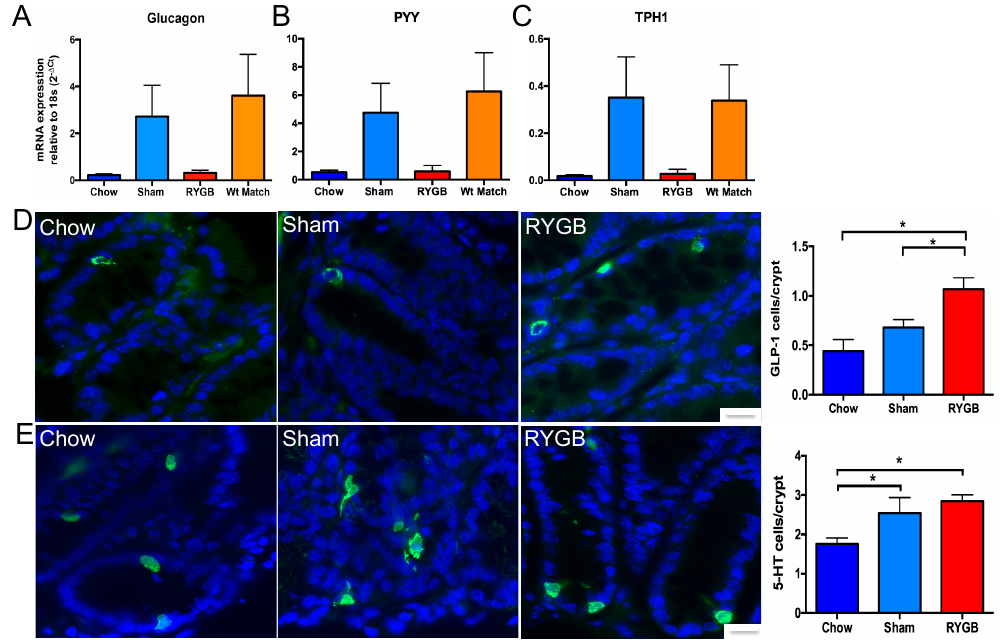
Figure 3. Colonic mRNA expressions of glucagon (the precursor to GLP-1), PYY, and TPH-1 (the enzyme required for 5-HT production) are elevated in sham and weight-match groups, but do not reach statistical significance ( A – C ). However, protein staining for GLP-1 show that RYGB significantly increases the number of GLP-1 containing L-cells compared to chow and sham groups ( D ). The number of 5-HT-containing EC cells increases in both sham and RYGB groups compared to chow groups ( E ). N = 5–7. Error bars show SEM, and significance is p < 0.05 as denoted by *. The scale bar = 5 µ